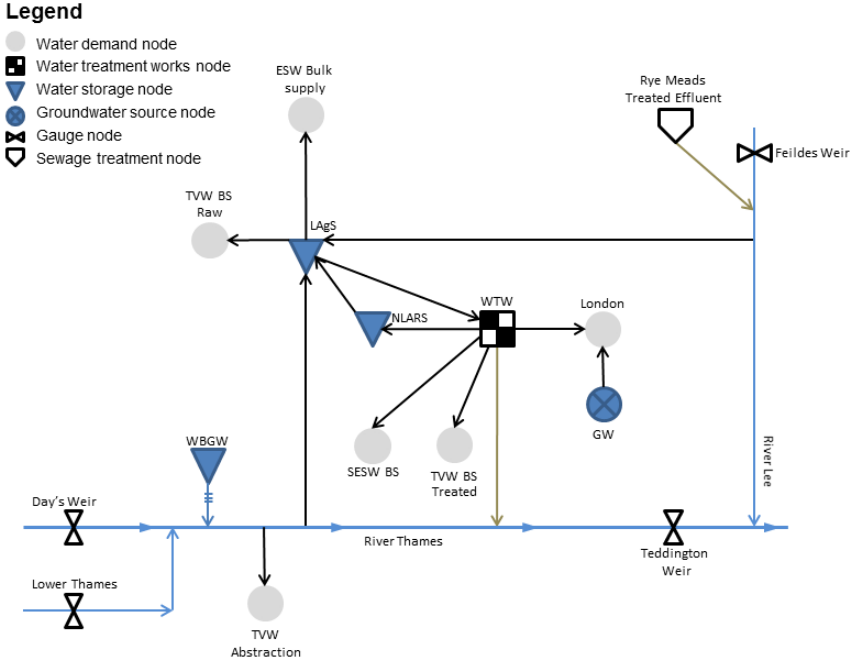
Figure 4. A schematic of LARaWaRM indicating the various water resource system components and interactions. (NB: groundwater is included as an aggregate inflow of 467.4MLday − 1 to meet London’s demand. A proportion of the inflow to the water treatment works is leakage; this is equivalent to 12% of demand and is returned back to the river and modelled as a contribution to the minimum environmental flow.) Table 1. Levels of service: restrictions and frequency of restrictions (Source: GLA, 2011; Thames Water, 2014). See Table S1 in the Supple- ment for reservoir total storage capacity trigger levels for the different levels of restrictions. Level of service Restrictions DS1 Media campaigns, additional water efficiency activities, en- hanced activity, and restrictions to reduce risk to water supply DS2 Enhanced media campaign, customer choice/voluntary con- straint, sprinkler ban. DS3 Temporary Use Ban (formerly hosepipe ban), Drought